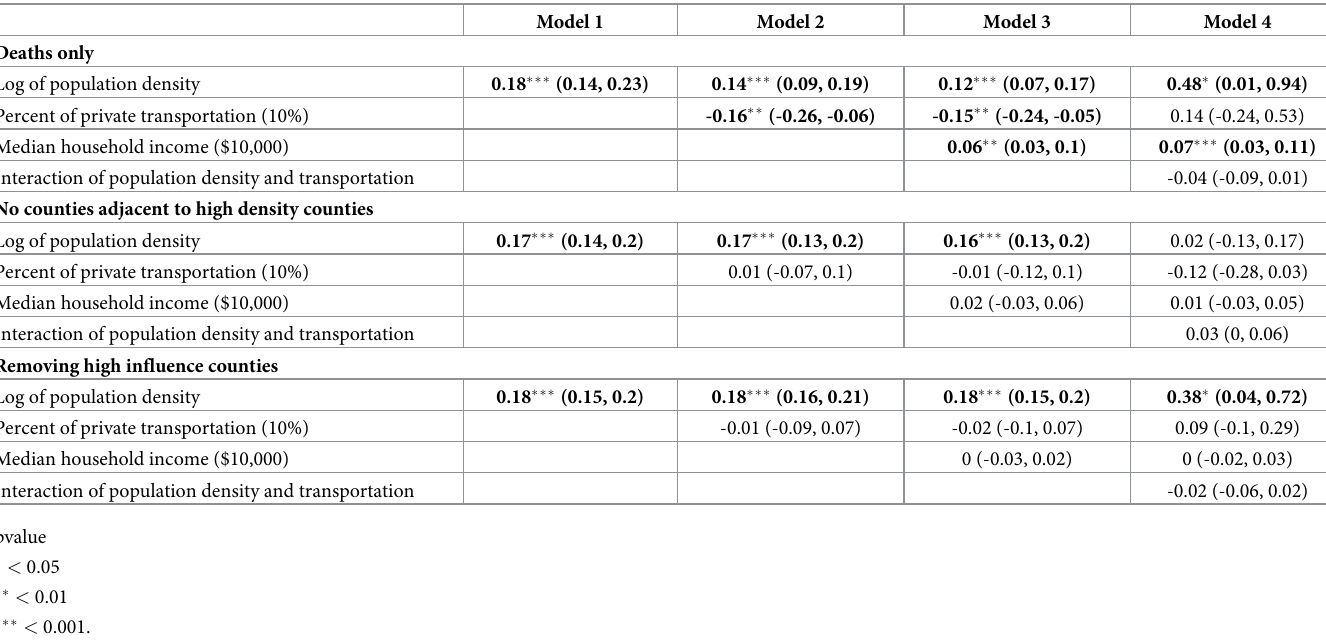
Table 2. Sensitivity analysis of linear mixed models (random intercept, fixed slope) using (a) deaths only, (b) removing counties within 15 miles of high-density counties, and (c) removing high influence